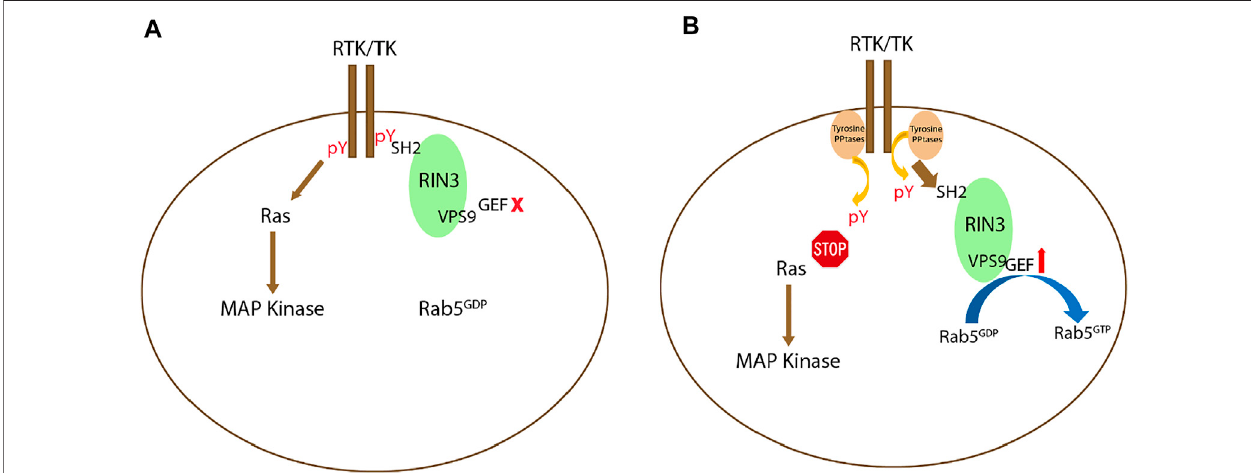
FIGURE 3 | Potential signaling mechanism(s) regulating RIN3 GEF activity. (A) : Upon activation of receptor tyrosine kinase (RTK) or tyrosine kinase (TK), while the Ras/MAP kinase signaling cascade is activated, RIN3 also via its SH2 domain binds to the phosphor-tyrosine residue (pY) leading to suppression of the GEF activity of RIN3and Rab5staysasGDPbound. (B) :Deactivation ofRTK/TK bythephosphotyrosinephosphatase(PPtase)resultsinattenuationoftheRas/MAP kinase signaling. Concomitantly, RIN3 is decoupled and breaks free from RTK/TK, which in turn activates the GEF activity to promote the conversion of Rab5 from GDP- to GTP- bound